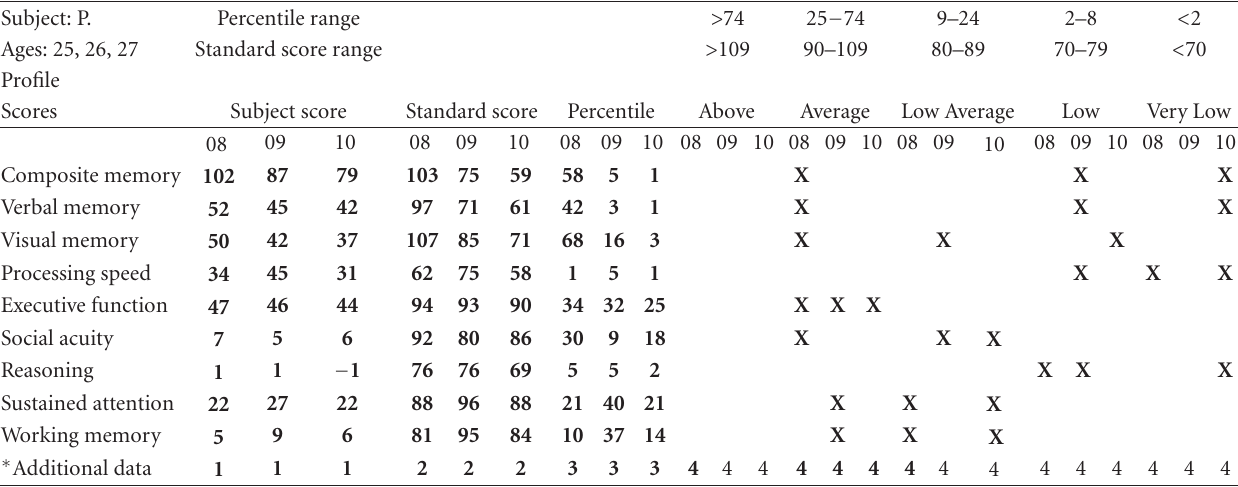
Table 2: Dashboard neurocognitive. Test Results CNSVS the years 2008, 2009, and